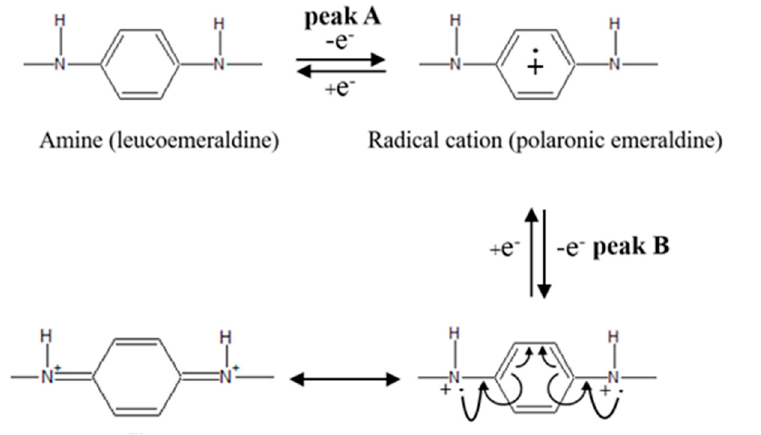
Scheme 1. The mechanism of the growing polyaniline.